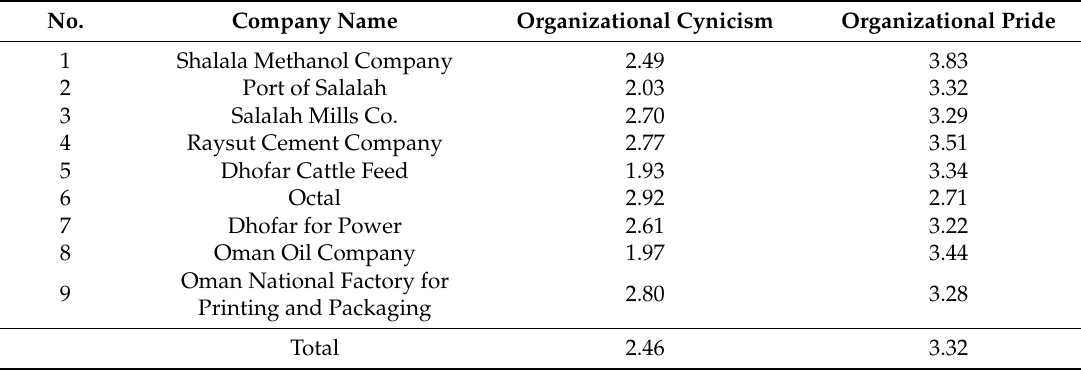
Table 4. Prevalence of organizational cynicism and organizational pride in companies.